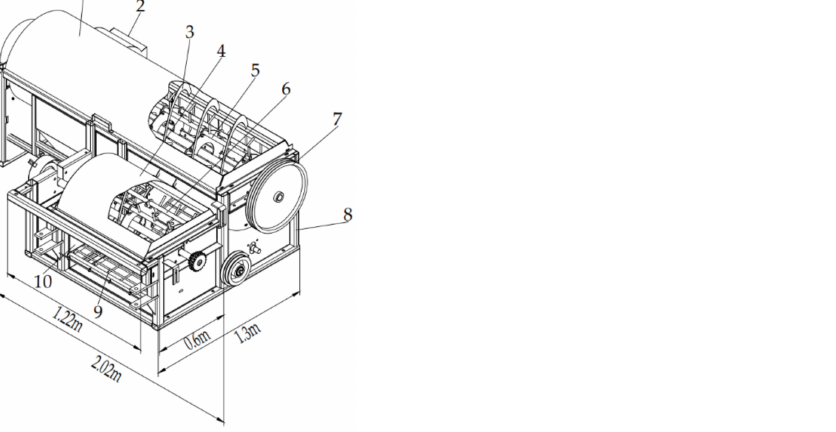
Figure 5. Schematic diagram of the structure of the tangential–axial-flow pod-pickup drum. 1. Enclo- sure of axial drum; 2. Seedling discharge port; 3. Axial drum deflector; 4. Enclosure of tangential drum; 5. Axial drum; 6. Tangential drum; 7. Main pulley; 8. Frame; 9. Concave grate; 10. Plant inlet.